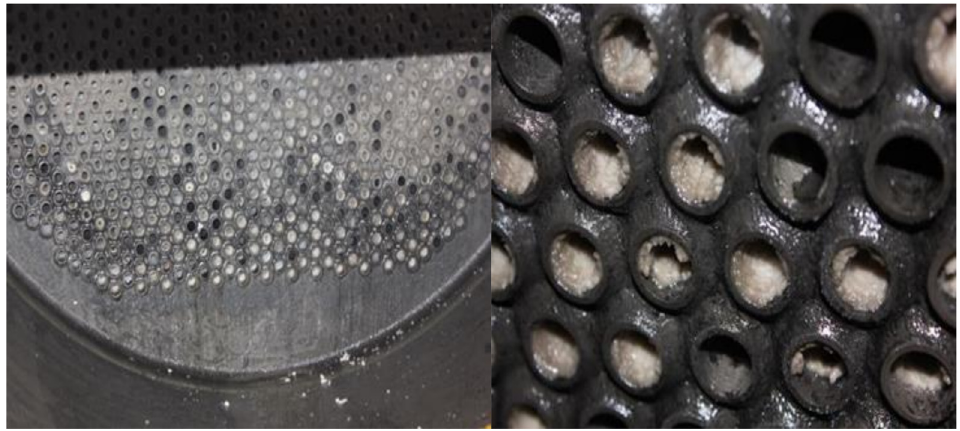
Figure 1. Scaling morphology of the heat exchanger tube